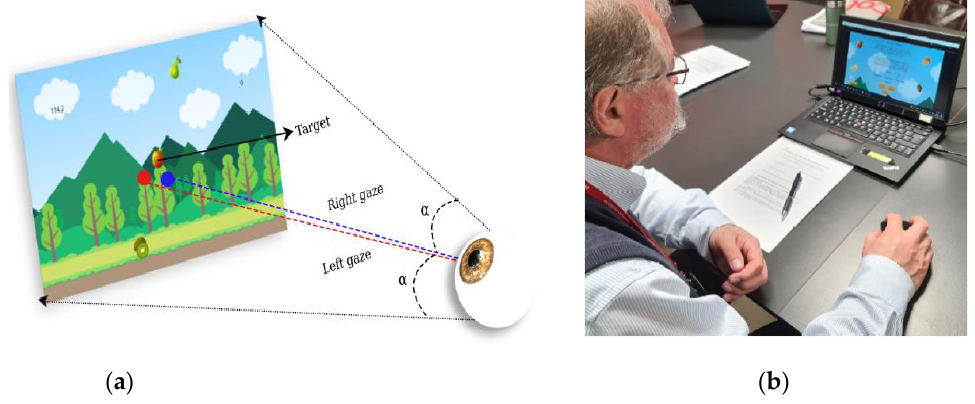
Figure 7. The left side (a) of the picture illustrates the approach of gaze measurements on the target on the screen. This angle was able to correctly collect eye movement data. The right side (b) shows the participant sitting at a correct distance from the eye-tracker for reading the instructions before the game.